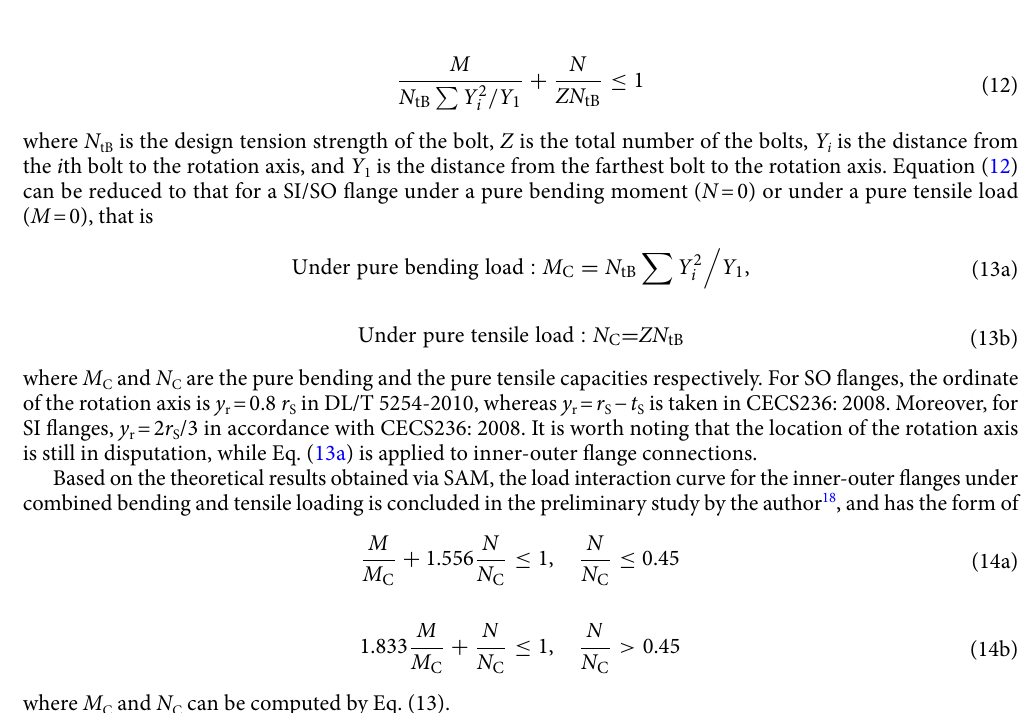
Table 5. Dimensions and capacities of specimens in Ref. 25 . *: “T” and “B” mean the tensile load and the bending moment